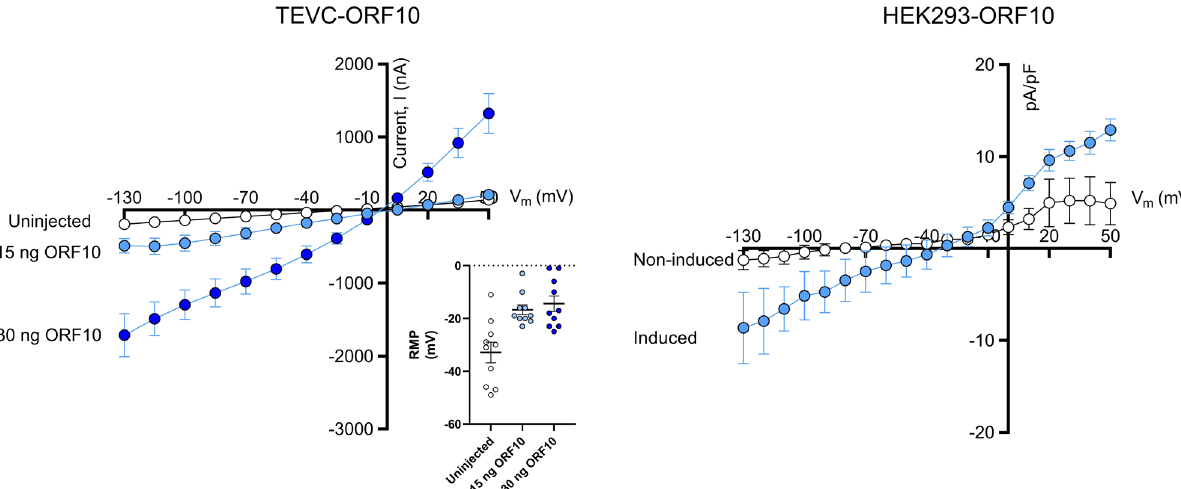
Fig. 1 SARS-CoV-2 ORF10 current voltage relationships. (Left) Two-electrode voltage-clamp (TEVC) current-voltage relationships of uninjected (white) X. laevis oocytes or oocytes injected with SARS-CoV-2 ORF10, 15 ng (light blue) or 30 ng (blue); oocytes were incubated for 3 days at 19 °C. Data are presented as mean ± SEM, n = 10. Inset shows resting membrane potential (RMP). (Right) Automated patch clamp (QPatch) current-voltage relationships of HEK293 cells expressing SARS-CoV-2 ORF10 under tetracycline control, white: non-induced; blue: induced (48 h induction with 500 ng/mL tetracycline). Recordings were performed with physiological solutions. The extracellular solution consisted of (in mM): NaCl 145; KCl 4; CaCl 2 2; MgCl 2 1; 10 HEPES and 10 glucose. pH = 7.4. The intracellular solution contained (in mM): KCl 120; KOH/EGTA 31.25/10; CaCl 2 5.4; MgCl 2 1.75; HEPES 10; 4 Na 2 ATP (pH adjusted with KOH to 7.2). Data are presented as mean ± SEM, n = 5 – 6.